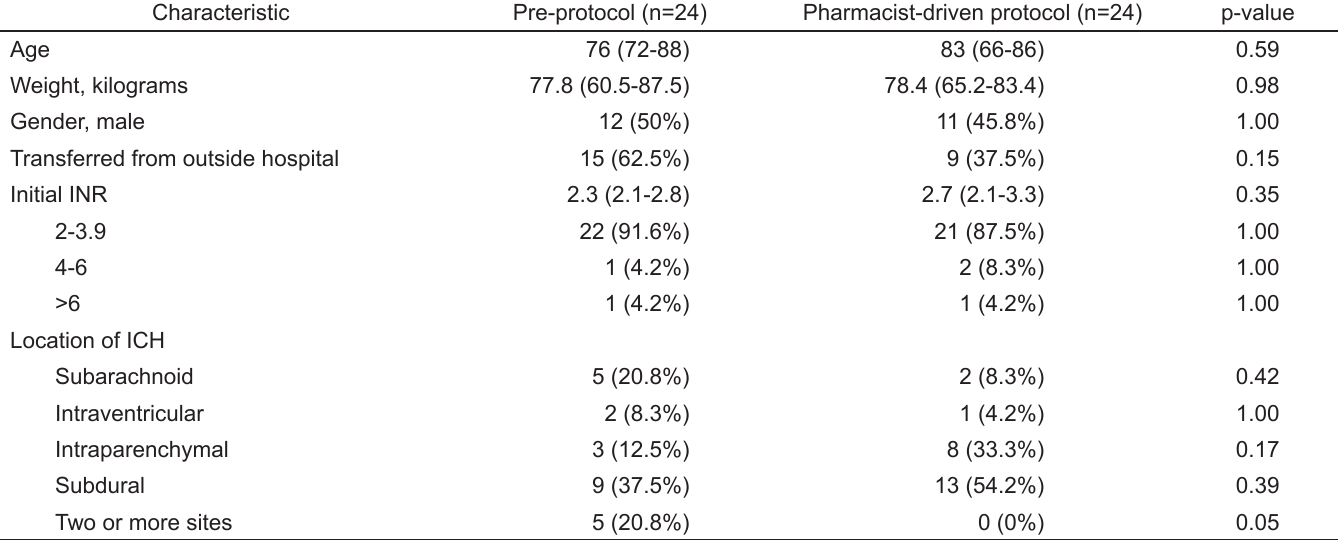
*All numbers are expressed as median (IQR) or n (%).